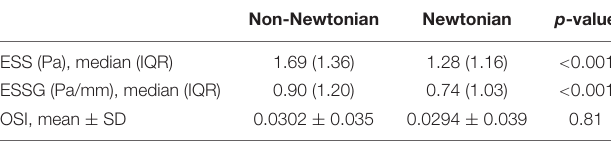
TABLE 1 | Patient characteristics. TABLE 2 | ESS, ESSG, and OSI between rheological models.